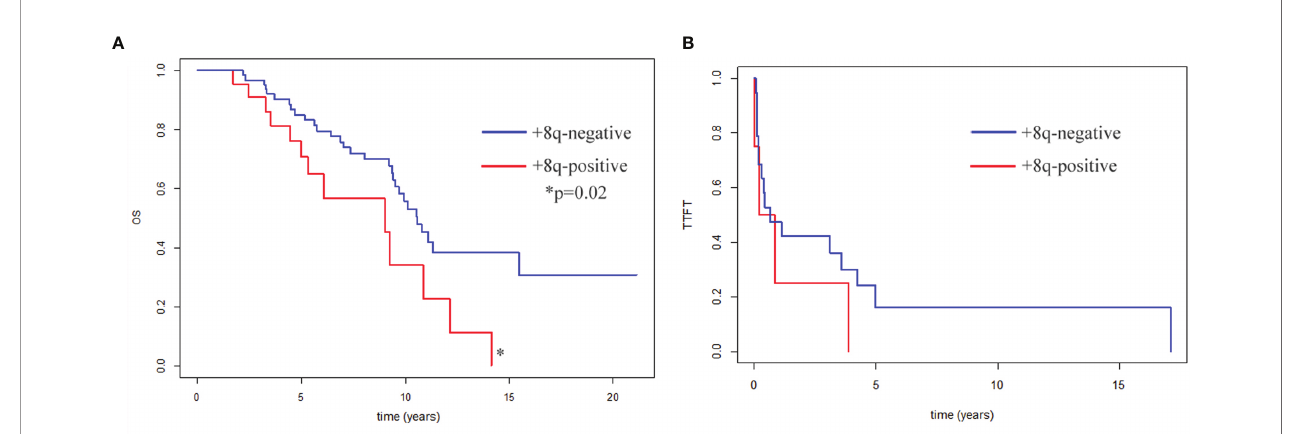
FIGURE 5 | (A) Kaplan – Meier curves for patients ’ overall survival (OS). OS of +8q-negative patients (n=63) and +8q-positive patients (n=22) was compared. Patients after bone marrow transplantation (n=3) were excluded from the OS analysis. (B) Kaplan – Meier plots for time to fi rst treatment (TTFT). TTFT of +8q-negative patients (n=64) and +8q-positive patients (n=24) was compared. Differences were evaluated by a logrank test. A statistically signi fi cant difference (p=0.02) is marked by an